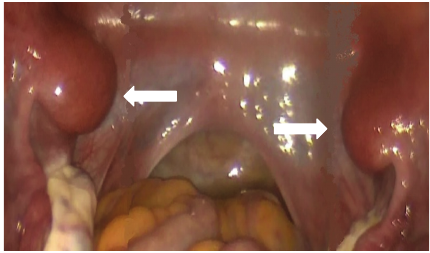
Figure 2: Pelvic exploratory laparoscopy showing bilateral ectopic rudimentary (hypoplastic) uteri measuring approximately 2 × 2 cm and attached to right and left pelvic sidewalls (arrows) with empty